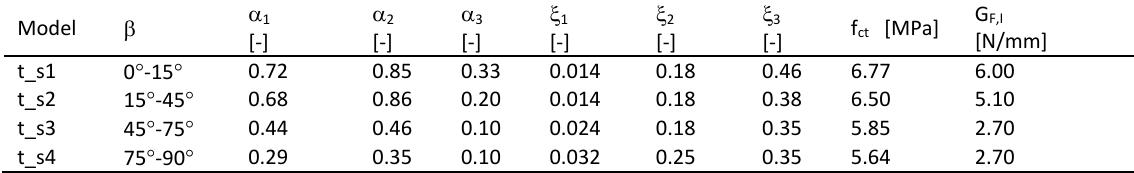
Table 3. SFRC fracture parameters defining a quadrilinear tensile stress – strain softening diagram for four distinct fibre orientation profiles.